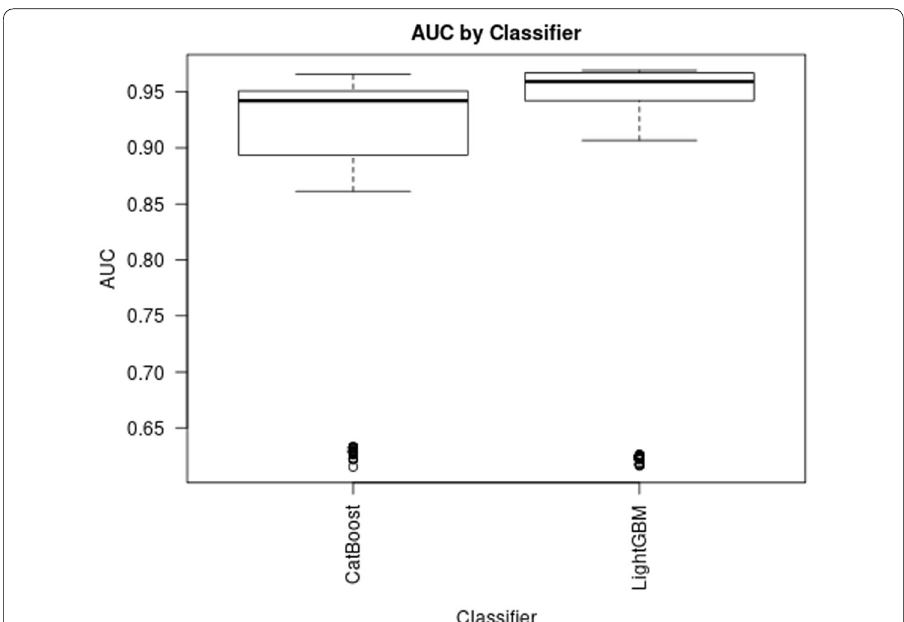
Fig. 9 Box plots of AUC grouped by classifier; Tukey’s HSD test indicates classifiers are significantly